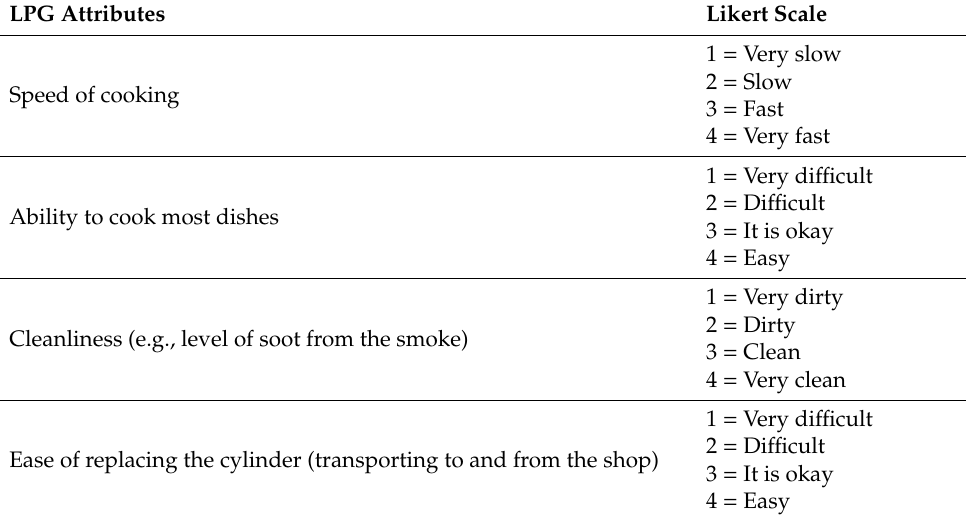
Table 1. Perceptions of LPG assessed through the questionnaires, with associated Likert